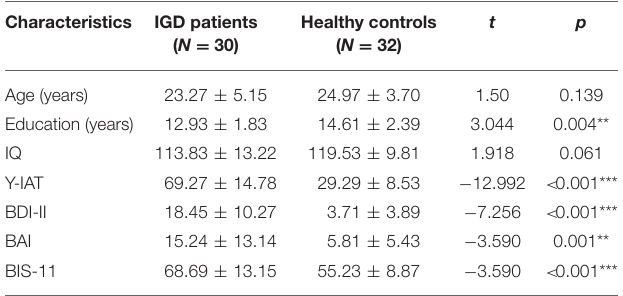
TABLE 1 | Demographic and psychological characteristics of the study groups at baseline. Characteristics IGD patients ( N = 30)